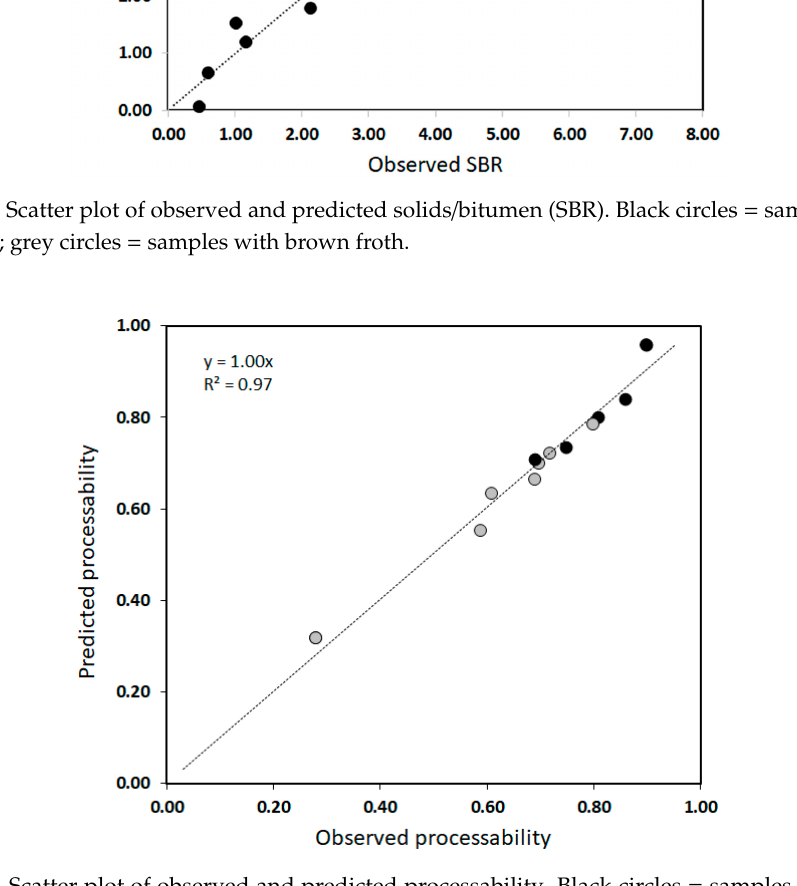
Figure 12. Scatter plot of observed and predicted processability. Black circles = samples with dark froth; grey circles = samples with brown froth.